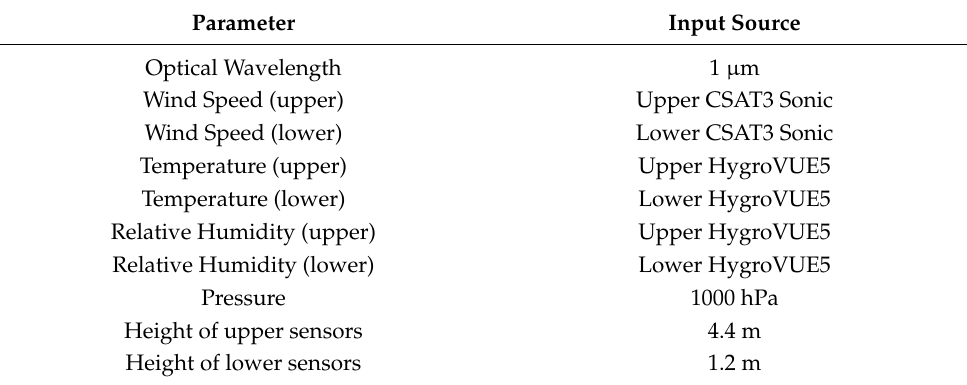
Table 1. Inputs to NAVSLaM for modeling C 2 n